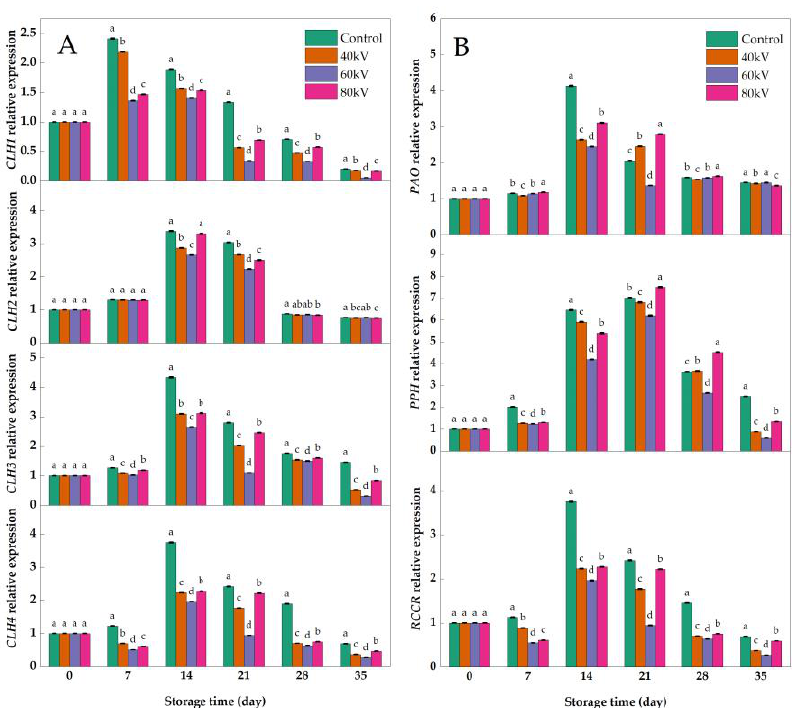
Figure 5. Effects of different intensities of ACP treatment on the relative expression of tomato chlorophyll catabolic genes CLHS , PAO , PPH , and RCCR : ( A ) CLHS relative expression; ( B ) PAO , PPH , and RCCR relative expression. Bars labeled with different small letters (a–d) indicate significant differences among different ACP treatments at the same storage time ( p ≤ 0.05).